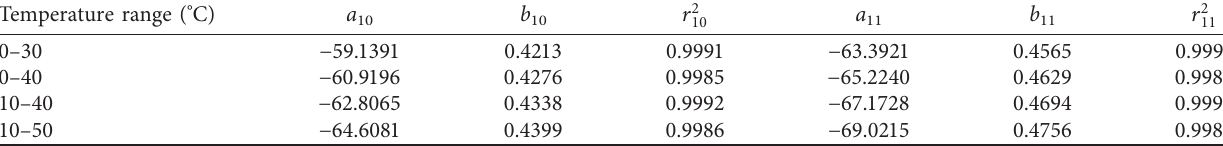
and r 2 are the determinants of the fit). 10 11